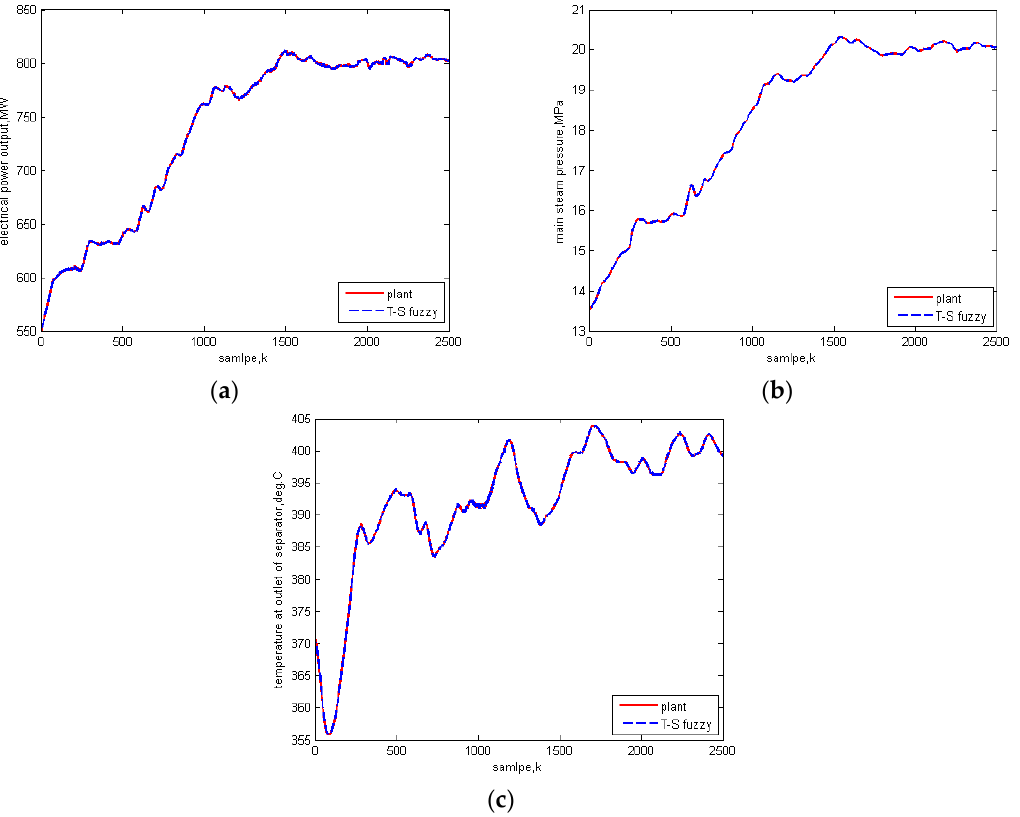
Figure 6. ( a ) Comparison of the T ‐ S fuzzy model and new test data 1 for electrical power output; ( b ) Comparison of T ‐ S fuzzy model and new test data 1 for main ‐ steam pressure; ( c ) Comparison of T ‐ S fuzzy model and new test data 1 for the separator outlet steam temperature.